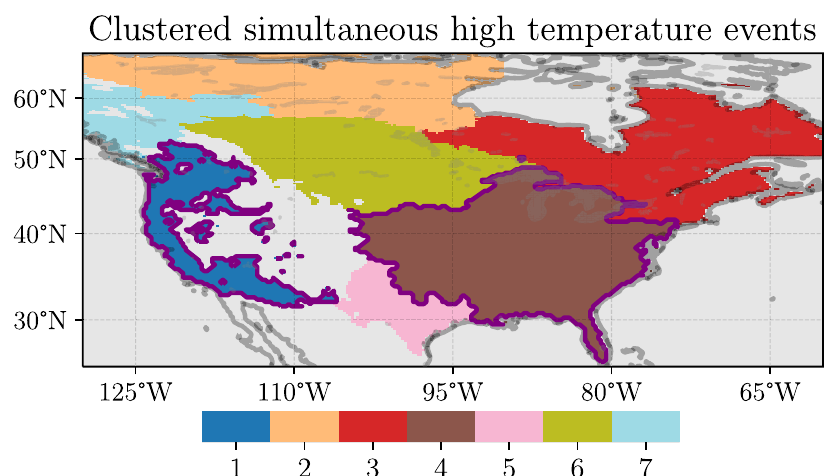
Fig. 8 Gridcells which show more frequent simultaneous warm temperature periods occurrences are combined using Hierarchical agglomerative clustering. Warm temperature periods are de fi ned as 15-day mean temperature exceeding the 66th percentile. The white gridcells indicate (the Rocky) mountains (altitude > 1500 metre). These were left out of the analysis because temperature variability at high altitudes might have a different relationship with Rossby wave variability compared to low altitude gridcells. The purple contour lines indicate the western and eastern US spatial